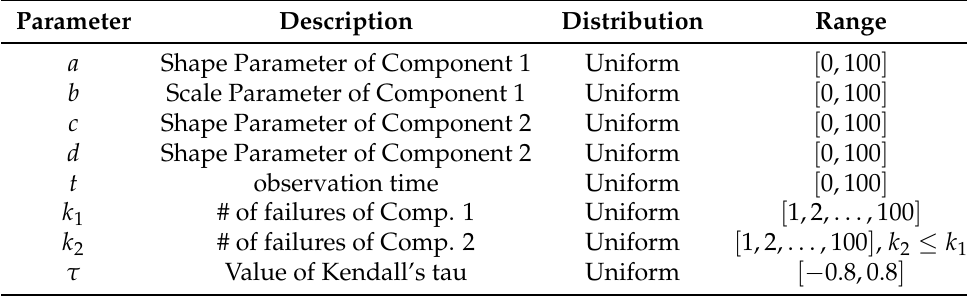
Table 1. Statistical distributions of the pseudo